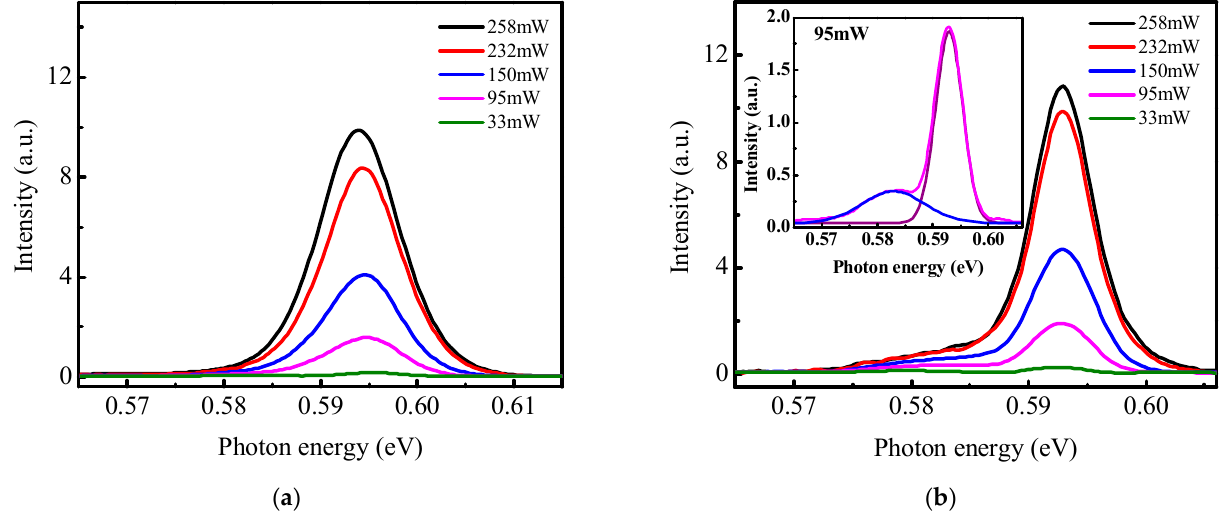
Figure 5. ( a ) PL spectra of extended wavelength InGaAs on InP substrate measured at 10 K (smoothed): ( a ) sample A and ( b ) sample B (the inset is Gaussian decomposition of PL spectrum at 95 mW).